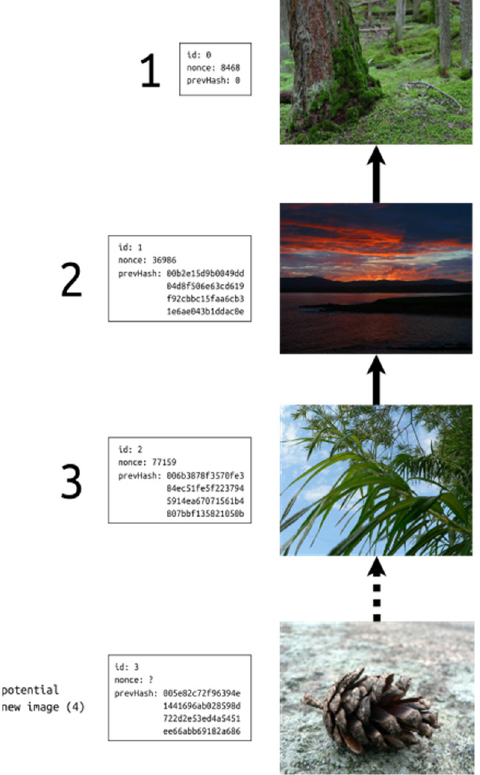
Figure 2. An example of a simple imagechain.